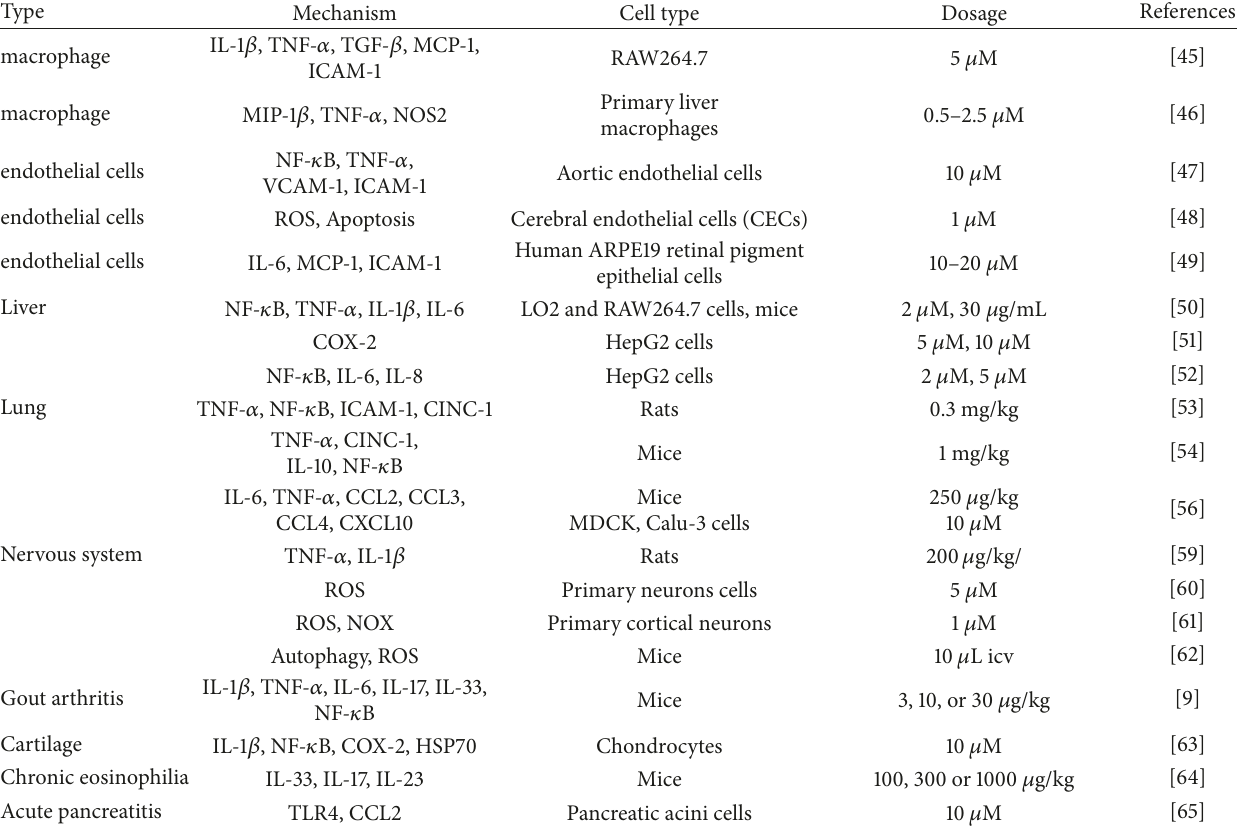
Table 2: Anti-inflammatory and antioxidant activities of 15d-PGJ2.